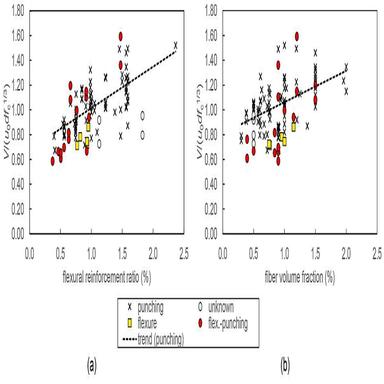
Normalized experimental failure loads of FRC specimens without shear reinforcement as a function of: a) flexural reinforcement ratio; b) fibre volume ratio.